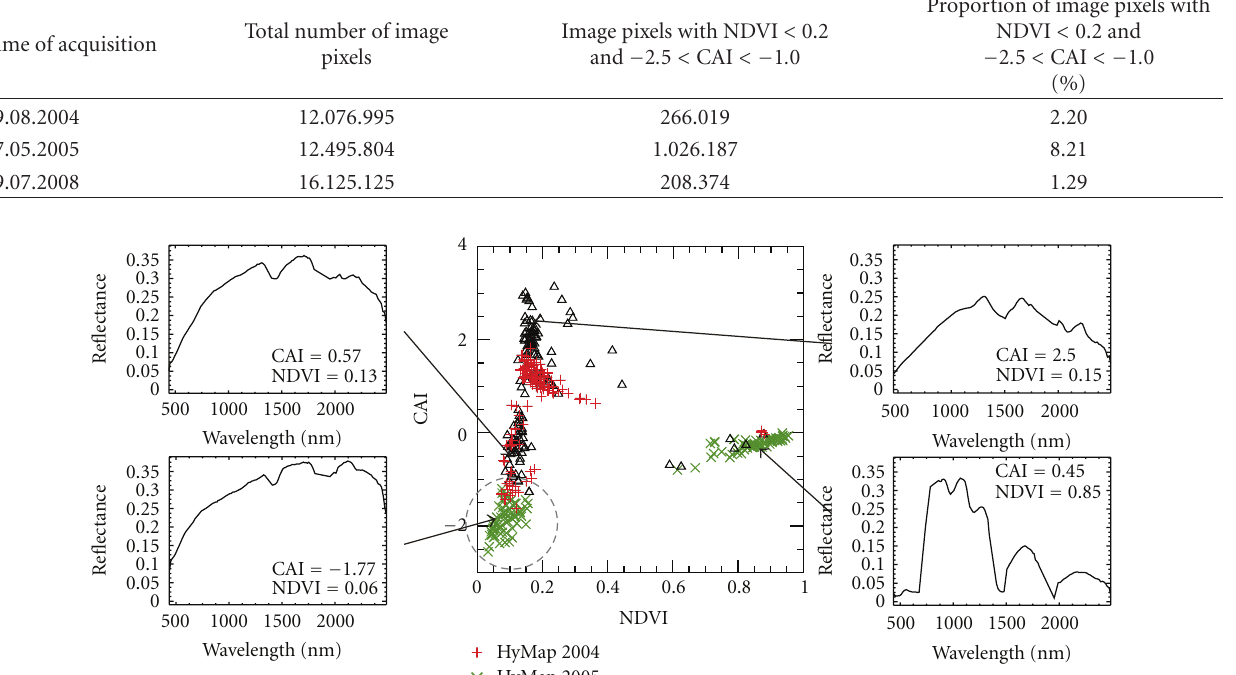
Figure 6: CAI versus NDVI derived from HyMap spectra of the years 2004, 2005, and 2008 of the 135 sampling points in the